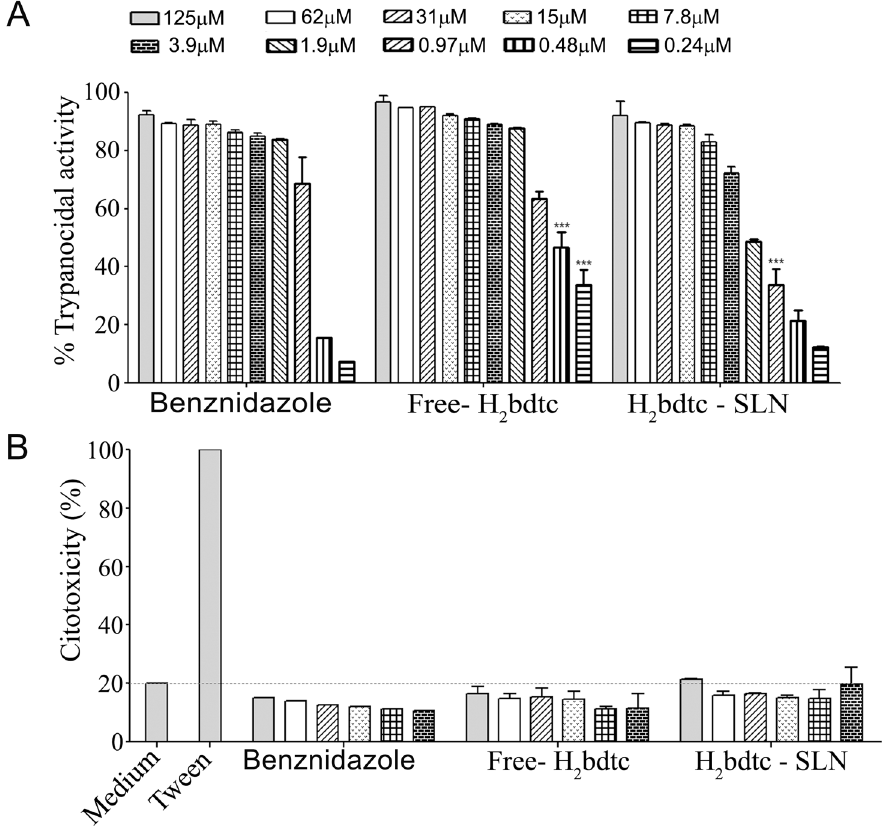
Figure 3. Invitro evaluation of the trypanocidal activity and cytotoxicity of H 2 bdtc – (concentrations range from 125 m M to 0.24 m M in serial dilutions). (A) Percentage of trypanocidal activity of free H 2 bdtc and H 2 bdtc loaded in SLNs against the Y strain of T. cruzi analyzed by quantifying viable parasites via microscopy after 24 h post-treatment. (B) Percentage of cytotoxicity of free H 2 bdtc and H 2 bdtc loaded in SLNs in spleen cells derived from mice after 24 h via propidium iodide treatment and FACS analysis. The mean + SEM is shown and is representative of three independent experiments (n=2). Statistically significant differences compared with the control (BZN). Anova, Bonferroni post - test: ***p , 0.001